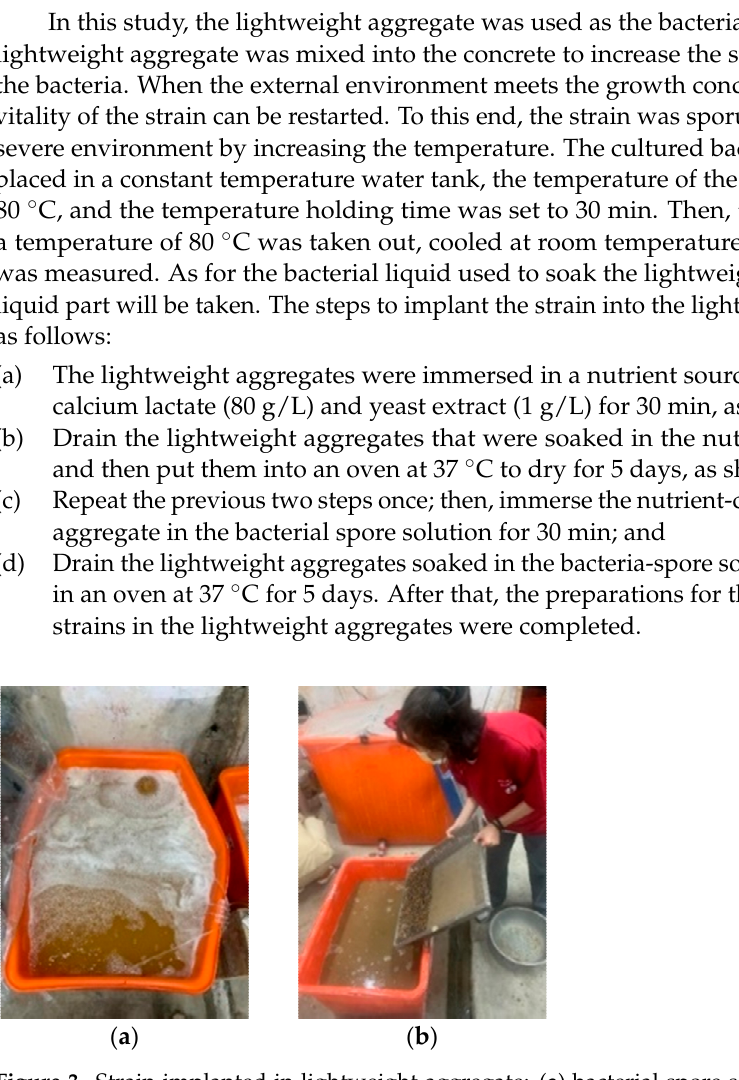
Figure 3. Strain implanted in lightweight aggregate: ( a ) bacterial spore solution; ( b ) lightweight aggregate dipped in bacterial spore solution.